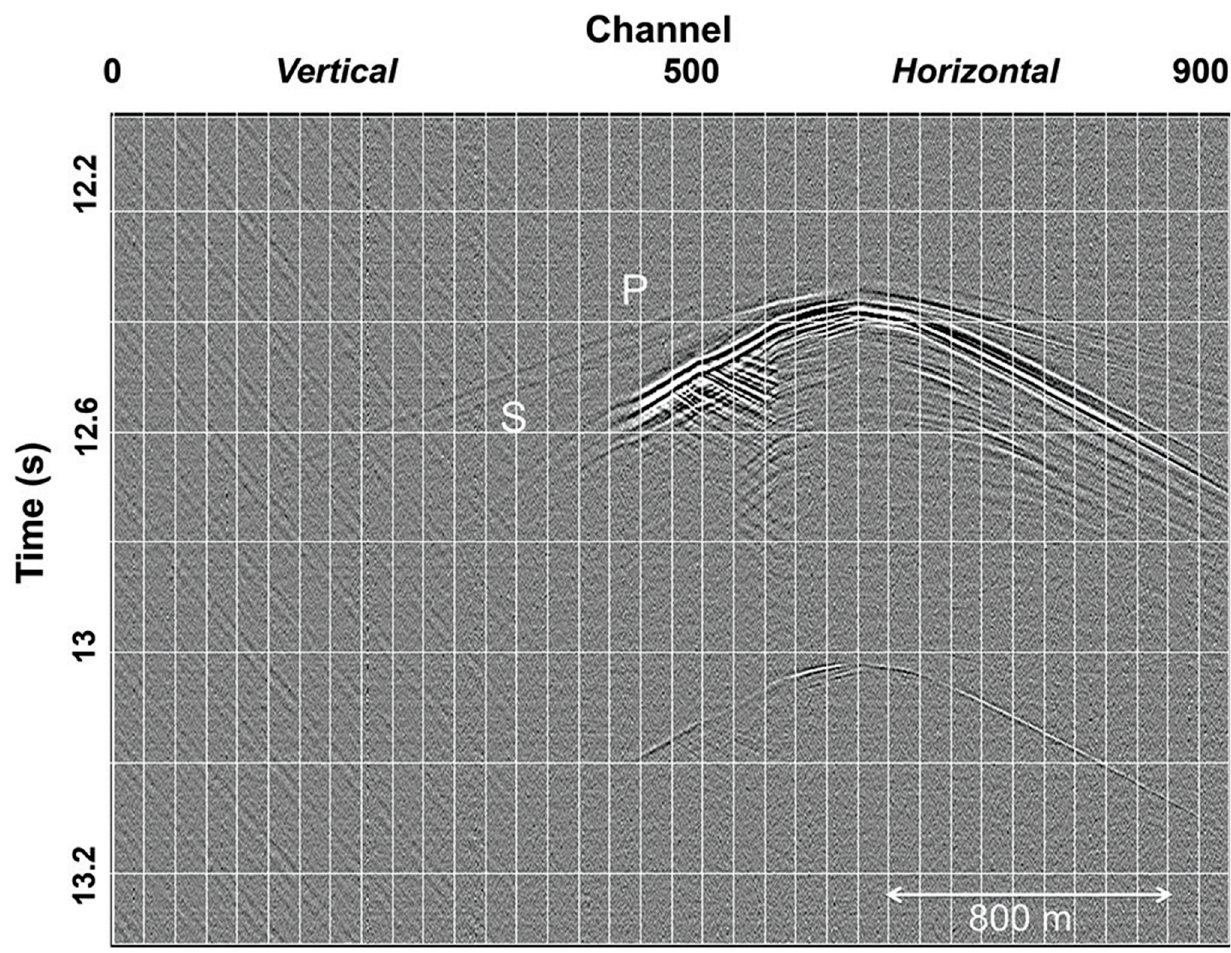
Figure 9. A microseismic event recorded with DAS in a deviated well. Direct P and S arrivals are visible and marked, but there are also reflections and coda events. Recording in the vertical part of the well has much lower SNR, as can also be seen in the later microseismic event that is only visible in the horizontal section. Figure from Karrenbach et al. (2017), The Leading Edge.